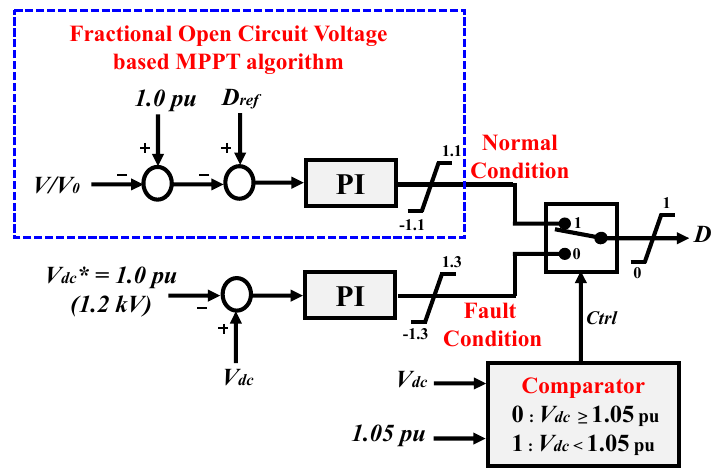
Figure 4. Boost converter controller of a PV plant.